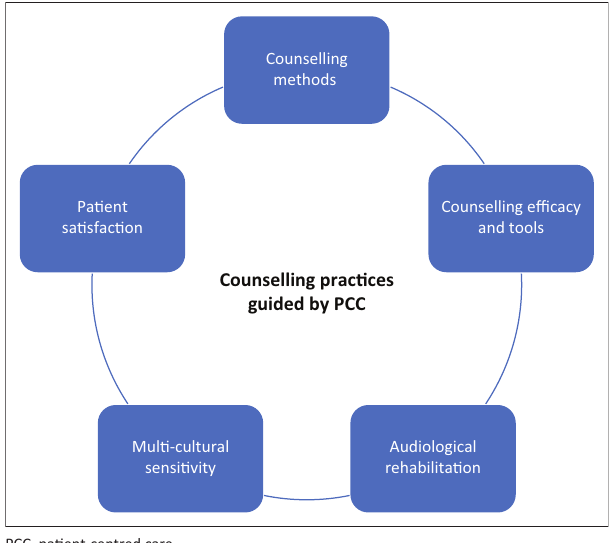
FIGURE 1: Conceptual framework adapted from patient-centred care, depicting aspects of counselling practices guided by patient-centred care that have been adopted for this